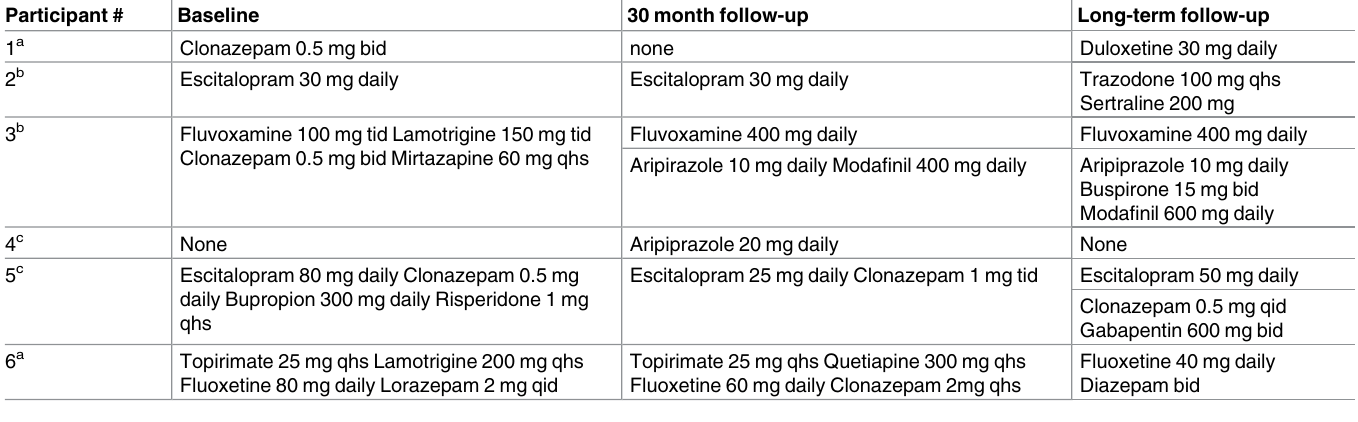
Table 4. Psychotropic Medications.